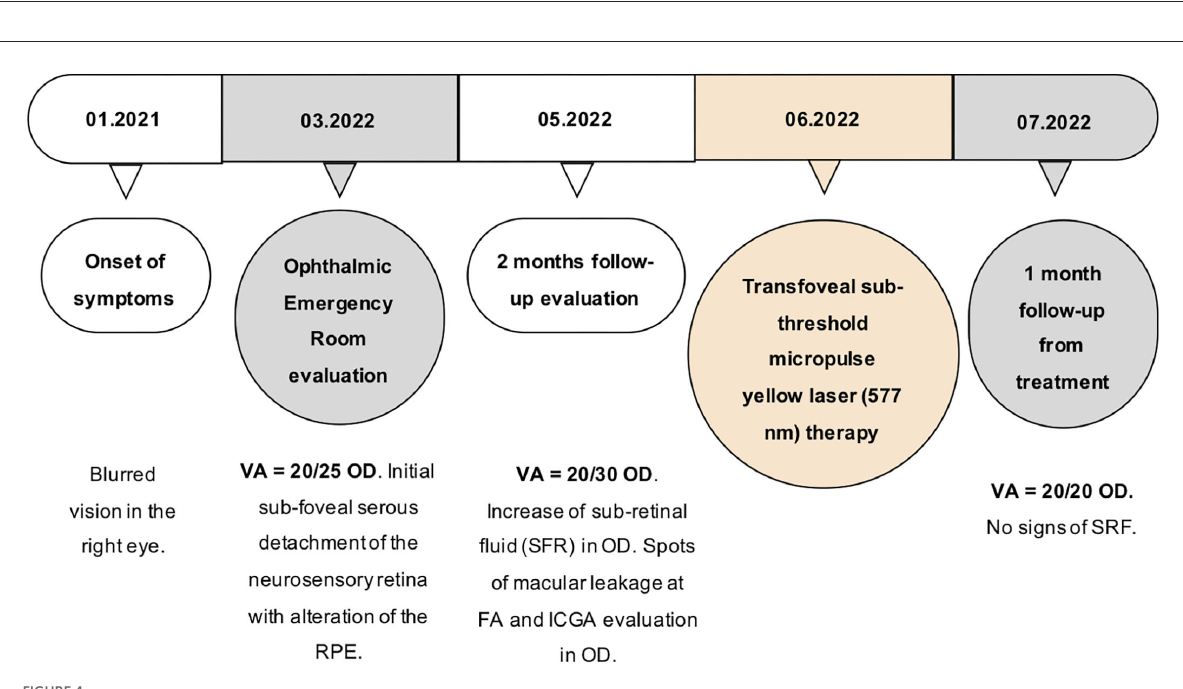
FIGURE4 Timeline of the main events that occurred to the patient. OD, oculus dexter; nm, nanometer; SRF, sub-retinal